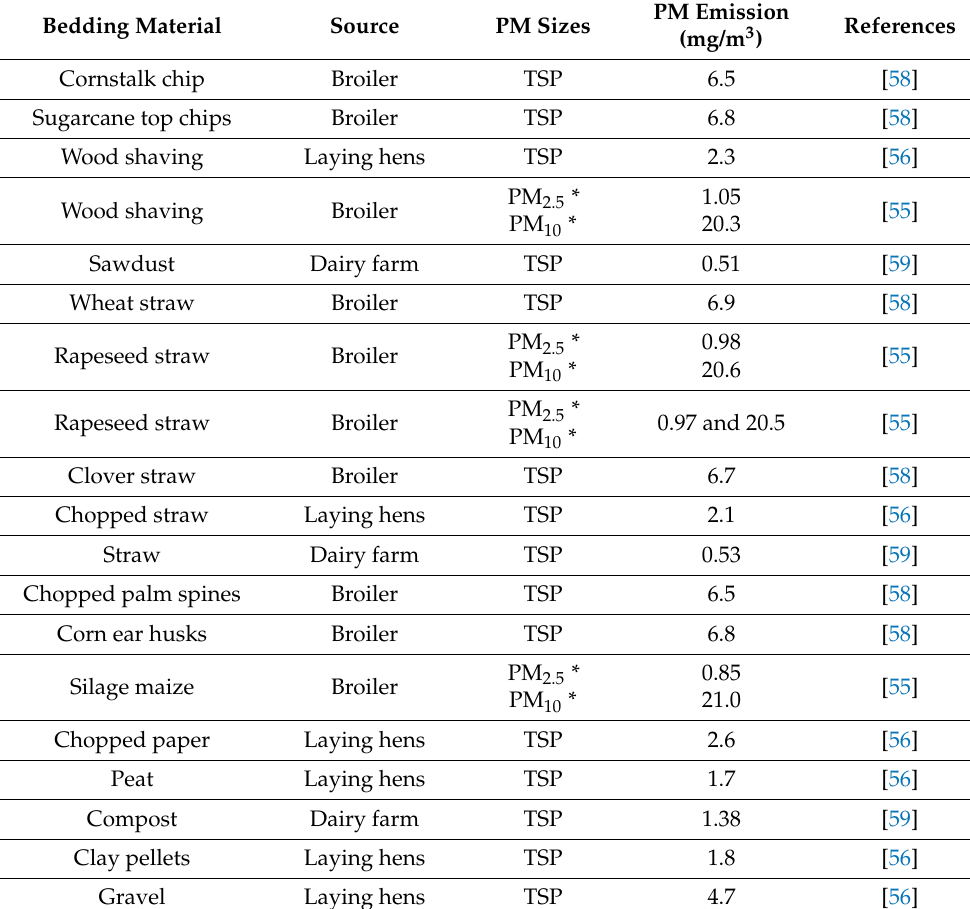
Table 3. Particulate matter emission due to different bedding materials used in the poultry housing